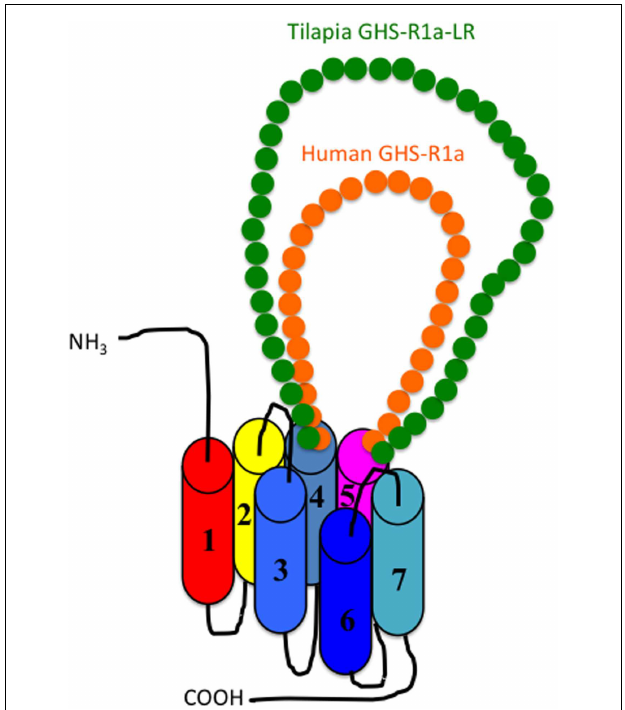
FIGURE 4 | Schematic diagram of the second extracellular loop (ECL2) in the GHS-R1a and GHS-R1a-like receptors . Human GHS-R1a, which has a short ECL2 (orange), and tilapia GHS-R1a-like receptor (GHS-R1a-LR), which has a long ECL2 (green), are shown as representative examples.The length of ECL2 in human GHS-R1a is 28 amino acids (AAs), whereas the ECL2 in tilapia GHS-R1a-LR is 43 AAs. Each receptor is classified in a different branch of the phylogenetic tree ( Figure 2 ). GHS-Ra, which includes GHS-R1a or 2a, is found in tetrapods including chickens (birds), mammals, reptiles, and amphibians, as well as some bony fishes such as Coelacanthiformes, Cypriniformes (e.g., goldfish, carp, and zebrafish), and Siluriformes (channel catfish).These animal species have the receptor with the short ECL2. In contrast, GHS-R1a-LR is found only in a fish group that includes Perciformes such as tilapia, Gasterosteiformes such as stickleback and medaka,Tetraodontiformes such as pufferfish, and Salmoniformes such as rainbow